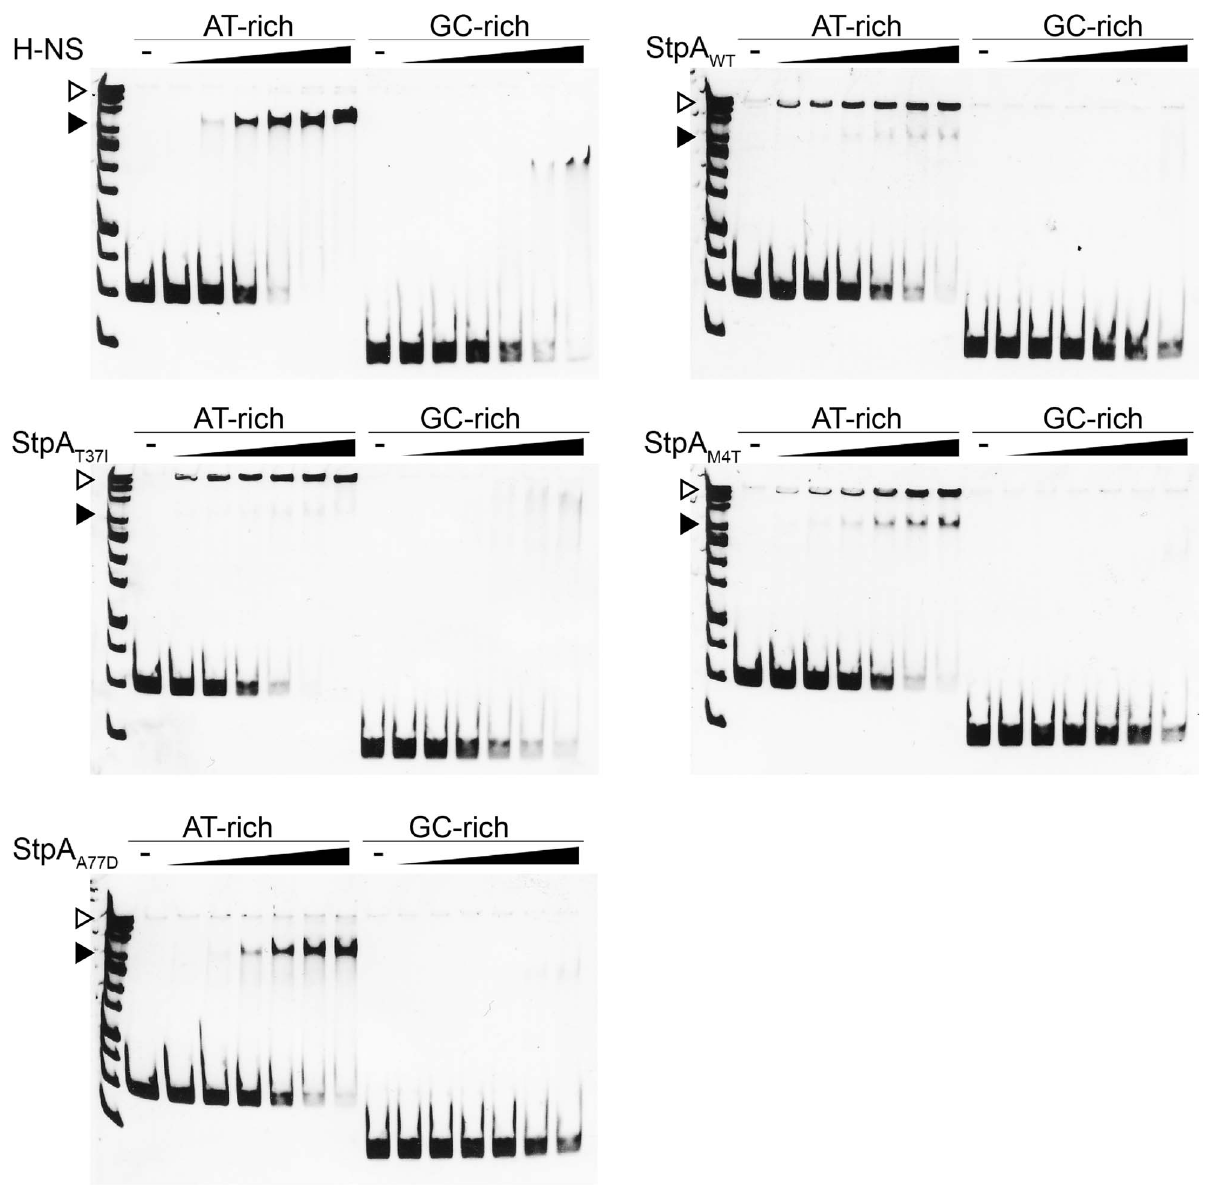
Figure 9. StpA M4T and StpA A77D form DNA-protein complexes more similar to H-NS than StpA WT . Electrophoretic mobility shift assays were conducted using purified H-NS, StpA WT , StpA T37I , StpA M4T , and StpA A77D . As indicated, the purified proteins were added to 289 bp AT-rich (%GC=34) or 204 bp GC-rich (%GC=74) model DNA fragments in increasing protein concentrations of 150 nM, 200 nM, 300 nM, 400 nM, and 500 nM. DNA/protein complexes were separated by 6% native polyacrylamide gel and stained with SYBR green. StpA complexes ( x ) migrated alongside the top band of a nucleotide standard, while H-NS complexes ( c ) migrated further into the gel as indicated.